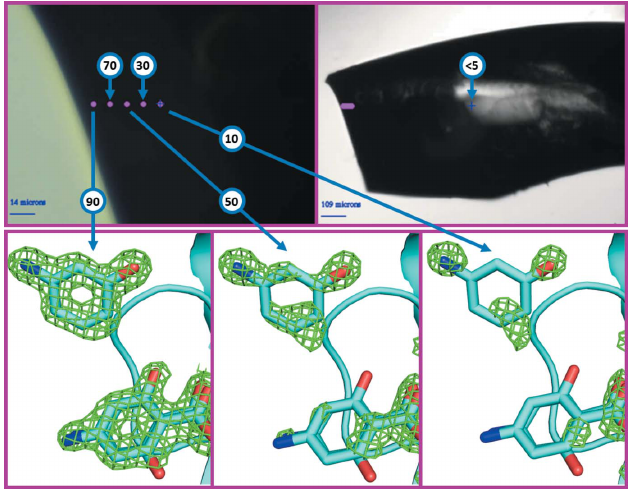
Figure 7 Diffraction data were obtained from one large lysozyme crystal soaked with 50 m M 4-aminosalicylic acid (PAS) and 50 m M 3-aminophenol (3AP) for 15 min prior to cryo-cooling. Diffraction data were obtained from five regions located near the crystal surface, in 10 m m shells (top left). Diffraction data were also obtained from the center of the crystal (top right). The observed occupancy from the near-surface shells was 90%, 70%, 50%, 30% and 10%, respectively (bottom). The observed occupancy from the center of the crystal was near zero (<5%).